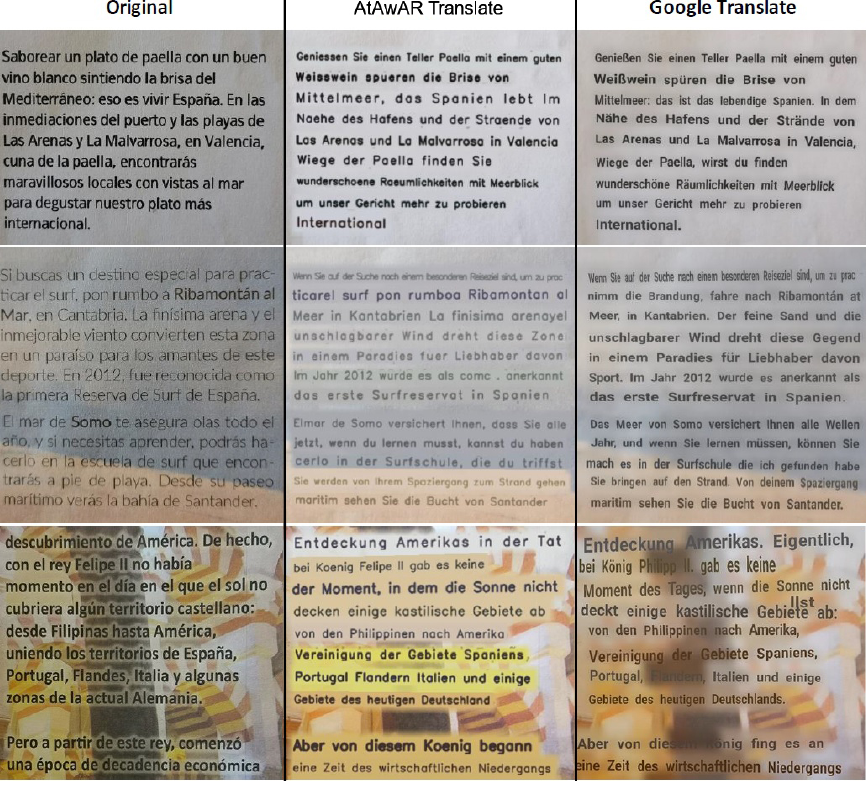
Figure 2. Comparison of the implemented AR translator (AtAwAR Translate), Google Translate and the original text for three different text and background